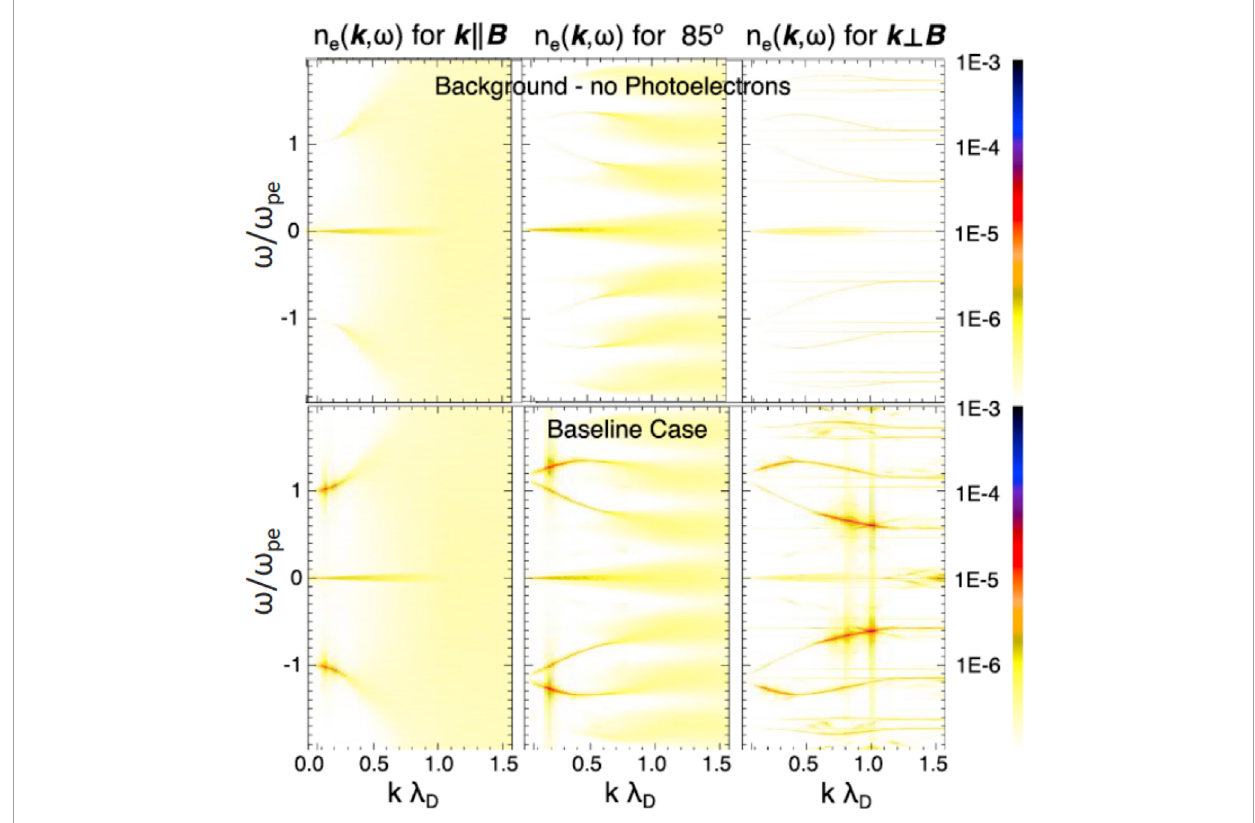
FIGURE 12 Electron density spectra at a range of angles with respect to B : (top row) without photoelectrons (“noise case”), and (bottom row) with photoelectrons (baseline case). The frequency is normalized to the plasma frequency ( ω pe ) , and the wave number is normalized to the Debye length ( λ D ) (from Oppenheim and Dimant, 2016, Figure